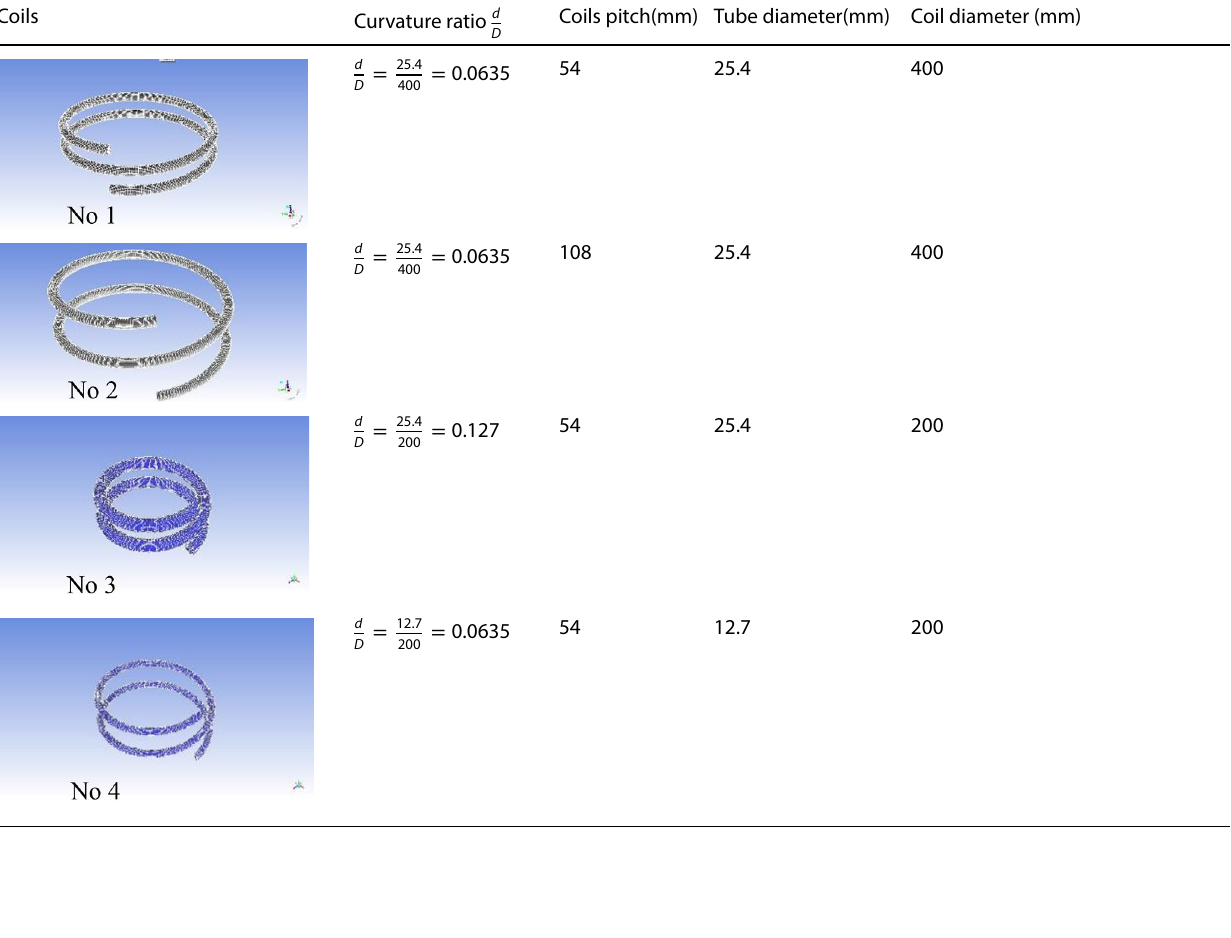
Table 5 Geometry description for different curvature ratio and coils pitch Coils